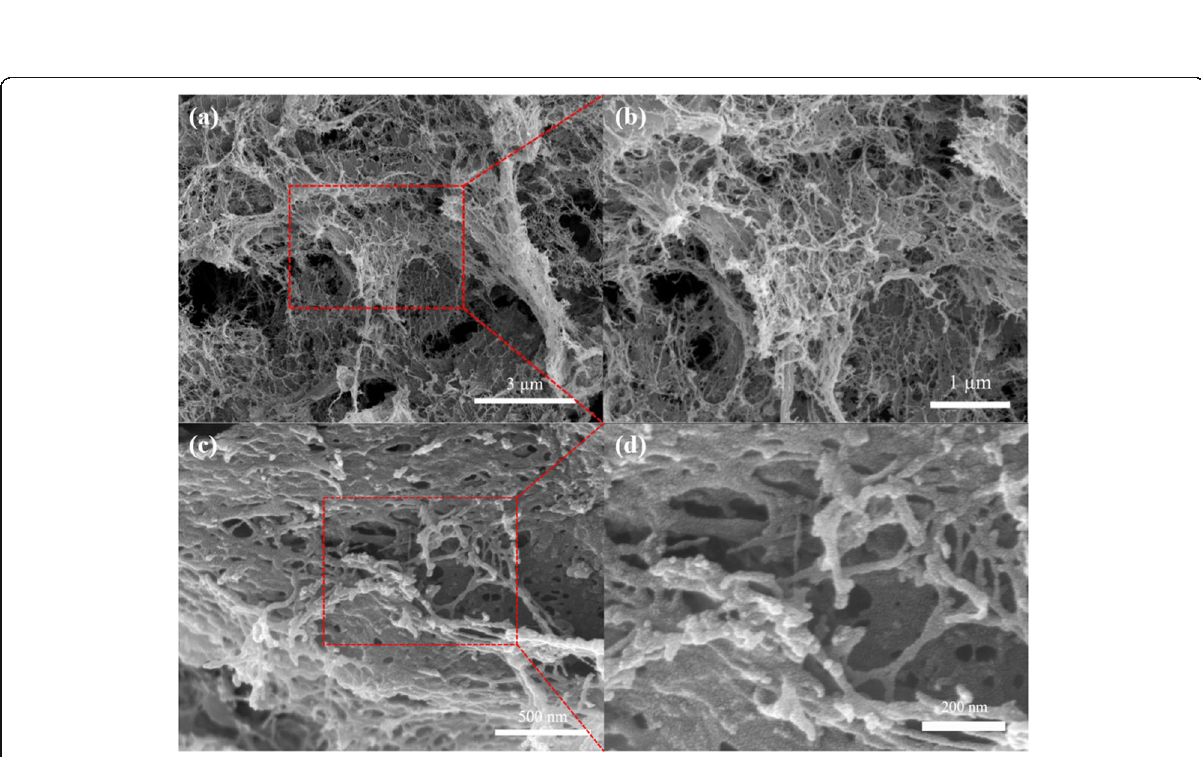
Fig. 2 a SEM image of the LC aerogel synthesized after 5 cycles of NFT; b enlarged area of Figure b ; c SEM images of the carbon aerogel prepared via the pyrolysis of LC aerogel under 1000 °C for 2 h; d enlarged area of Figure ( c